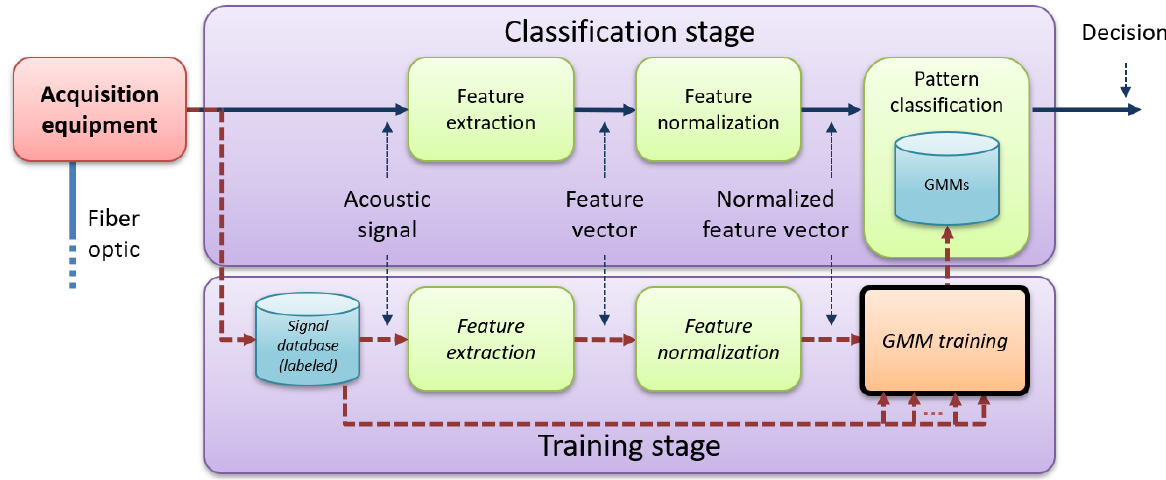
Figure 1. Architecture of the multi-position approach for detecting threats to the pipeline integrity. The module that appears in bold (i.e., Gaussian Mixture Model (GMM) training) is the new one with respect to [26].